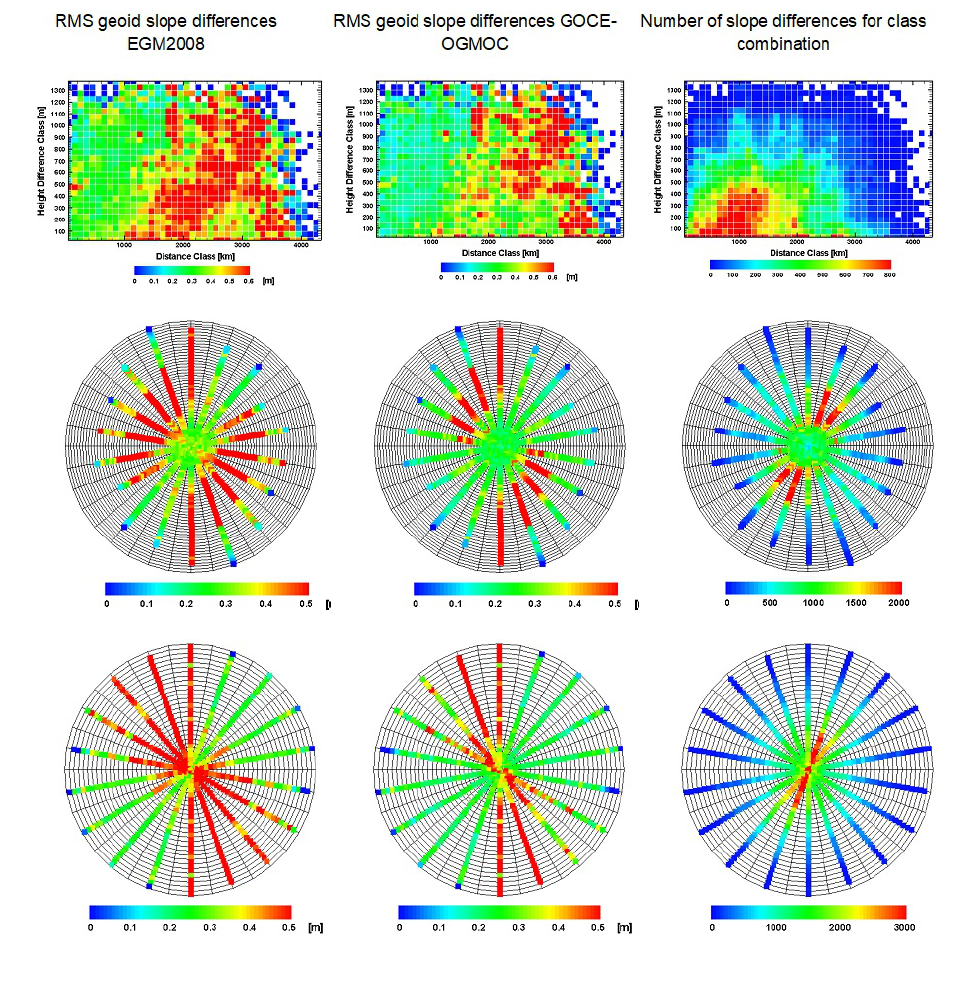
Fig. 7. RMS of geoid slope differences for the EGM2008 and GOCE-OGMOC high resolution models with full resolution (degree 2190) and GNSS-levelling points in Brazil (data set G02). The RMS value is computed and shown for the combination of two classes. 1. Row: Distance and height differences, 2. Row: Distance and orientation (circles represent distance classes in steps of 100 km), 3. Row: Height differences and orientation (circles represent height differenceclasses in steps of 50